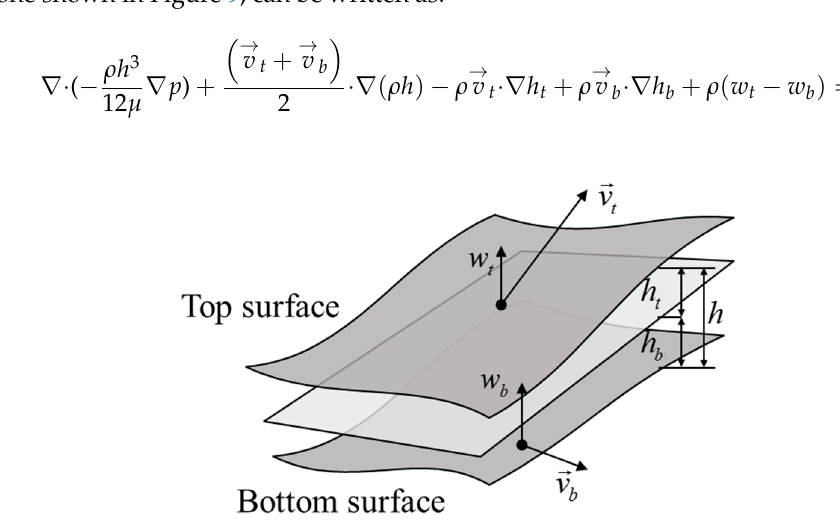
Figure 9. An arbitrary lubricating gap.